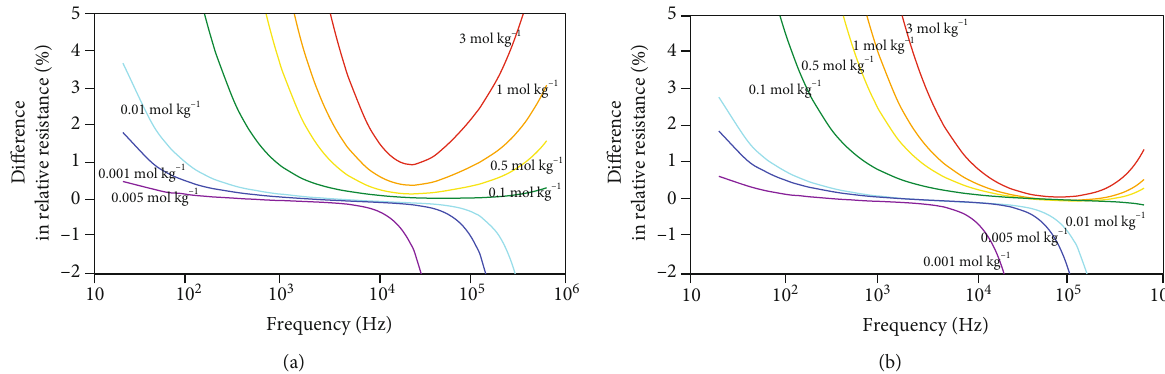
Figure 6: The di ff erence in relative resistance (%) observed for (a) ECM-1 and (b) ECM-2. The di ff erence between the resistance measured at each frequency and the calculated with extrapolation was described as a relative value.